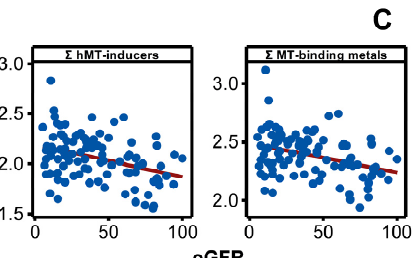
Figure 4. Variation in plasma metal levels as chronic renal failure progresses in CKDu endemic Padaviya area. Log10 transformed plasma metal levels (µg/mg protein, by ICPMS) were tested for ( A ) statistical significance among study groups (EC: endemic control, G1-G5: CKD stages, n = 97 − 98) by one way ANOVA/Tukey HSD. Data represent mean and 95% confidence interval. Letter pairs a and b, c and d, and e and f indicate statistical difference ( p < 0.05). Data of unaffected metals and metalloids are not shown. In Figure ( B , C ), associations with eGFR (mL/min/1.73 m 2 ) variants as kidney dysfunction markers by Pearson’s test are shown. Metals with rho weaker than ± 0.3 were not considered, and the strongest correlation by others is shown. In Figure ( B ), eGFR are CKD-EPI except for Co against MDRD. Figure ( C ) plots eGFR of CKD-EPI (sCr, CysC). All Y-axes and X-axes of Figure ( B , C ) are on linear scale.